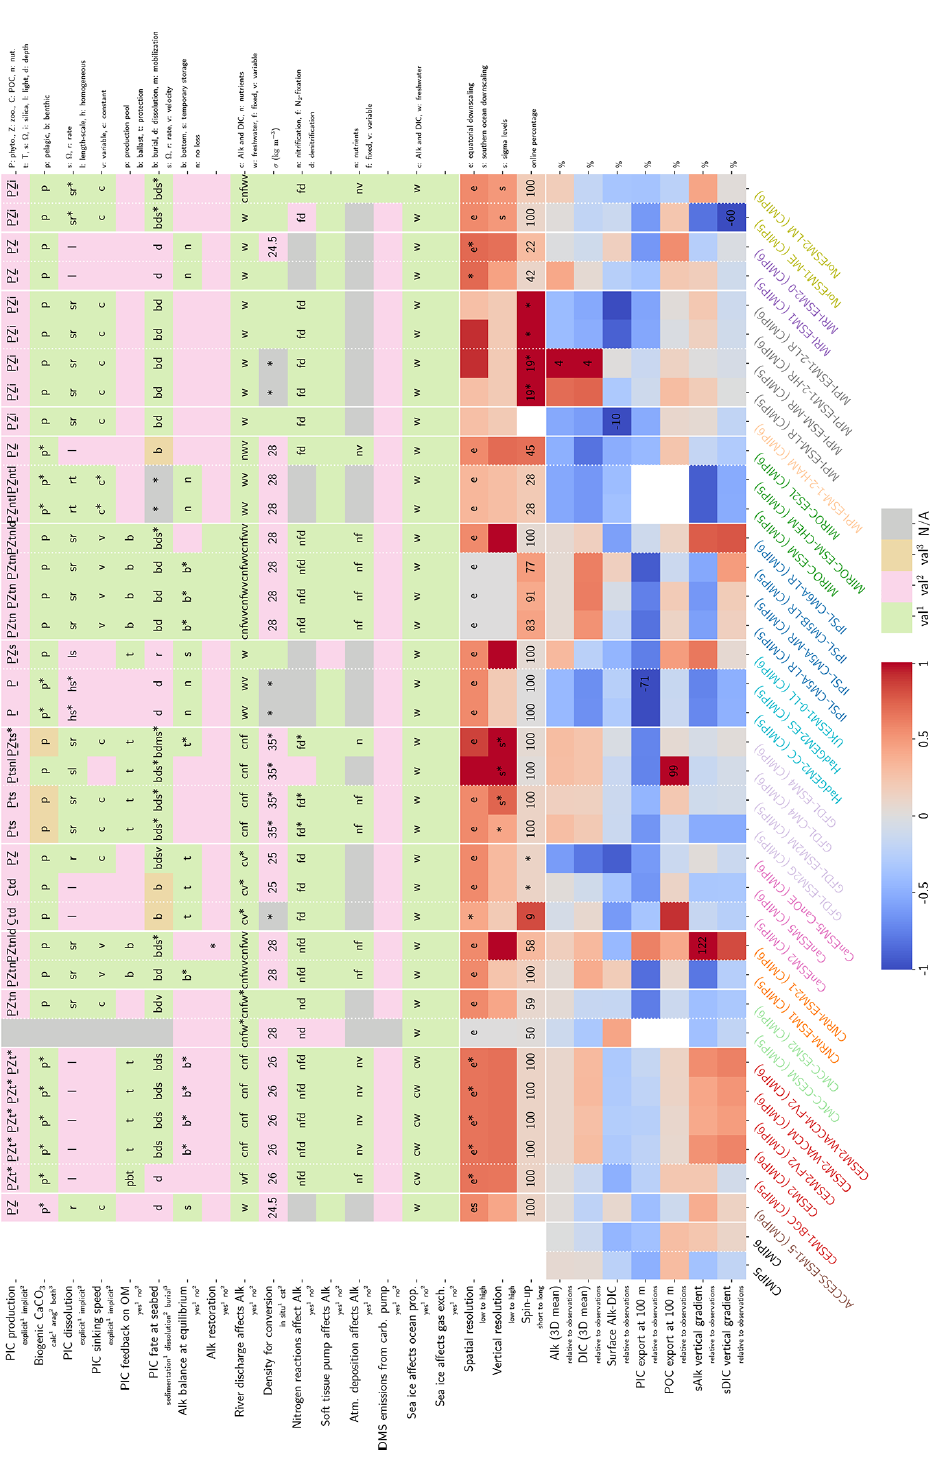
Figure C1. Model description and performance with respect to the representation of Alk and the carbonate pump (expanded from Figs. 2 and 10). Details include biogeochemical modelling schemes, resolution and spin-up, and model performance. For PIC production, underlined letters correspond to the explicitly modelled variables on which PIC production relies. Asterisks denote that further details can be found in Supplement Table S1. For the spin-up duration, the maximum value attributed was set to 8000 years to keep the differences between the other ESMs and MPI ones visible. Performance metrics are normalized between − 1 and 1 so that the model with maximum absolute bias corresponds to either 1 or − 1, and better-performing models have lighter cell colours. For each row, the value given for the ESM with the greatest bias corresponds to the percentage of the GLODAPv2 observational estimate that this bias represents. When information is missing, the cell is left